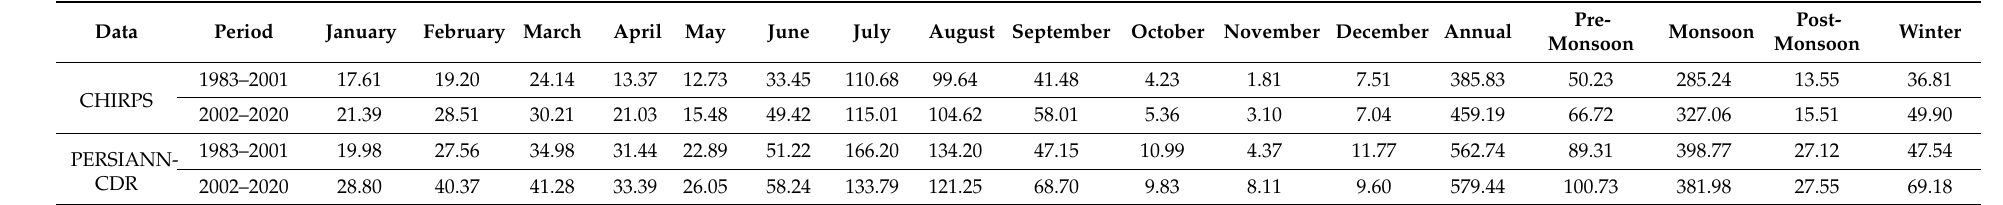
Table 3. Phase-wise annual, seasonal, and monthly distribution of rainfall in central Punjab from gridded datasets (1983–2020).